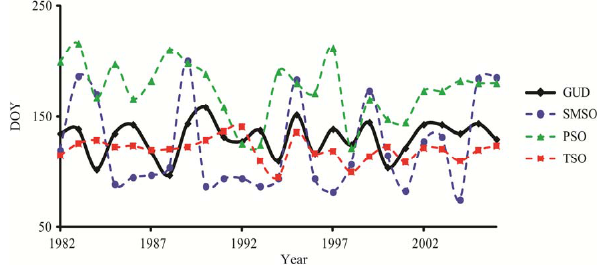
1 Fig. 9. Time series of SMSO (Soil Moisture Spring green-up Onset date), PSO 2 Fig. 9. Time series of SMSO, PSO, TSO, and GUD at station (Precipitation Spring green-up Onset date), TSO (Thermal Spring Onset date), and GUD 3 number 10. (Green-up Onset Date) at station number 10. 4